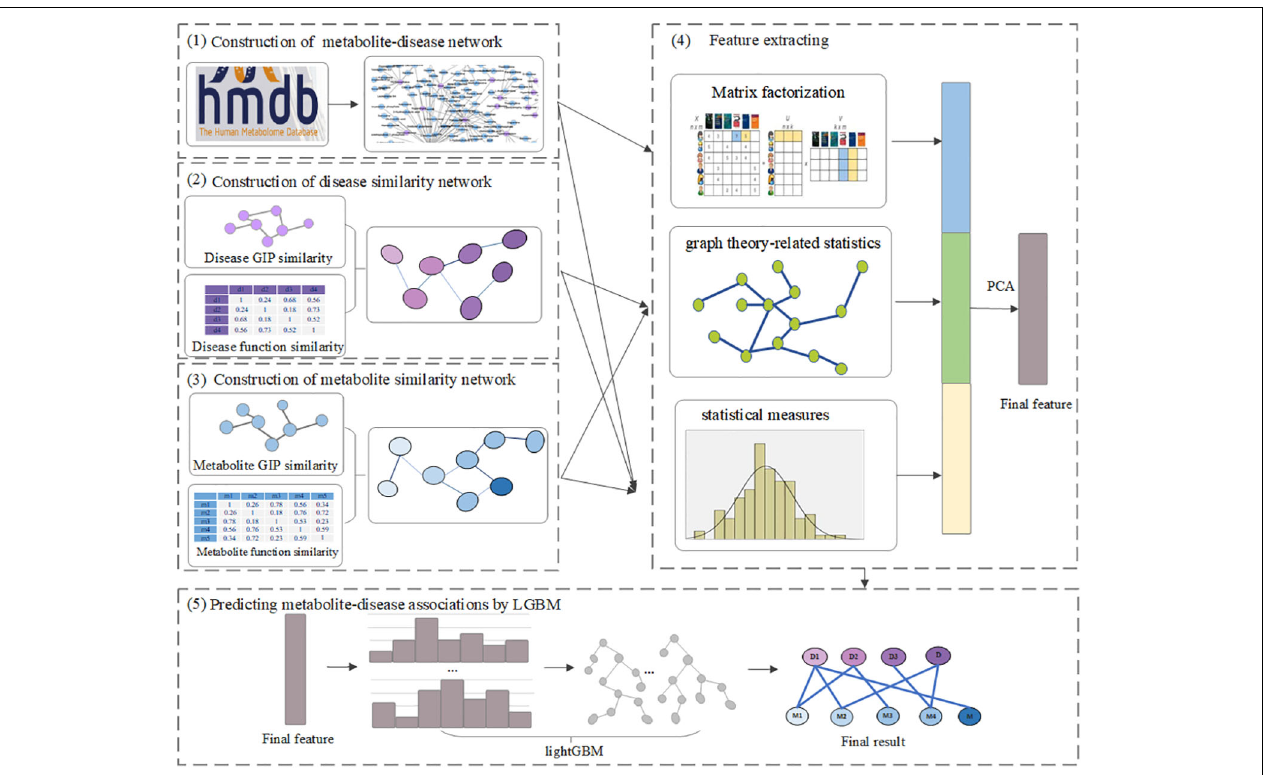
FIGURE 1 | The flowchart of